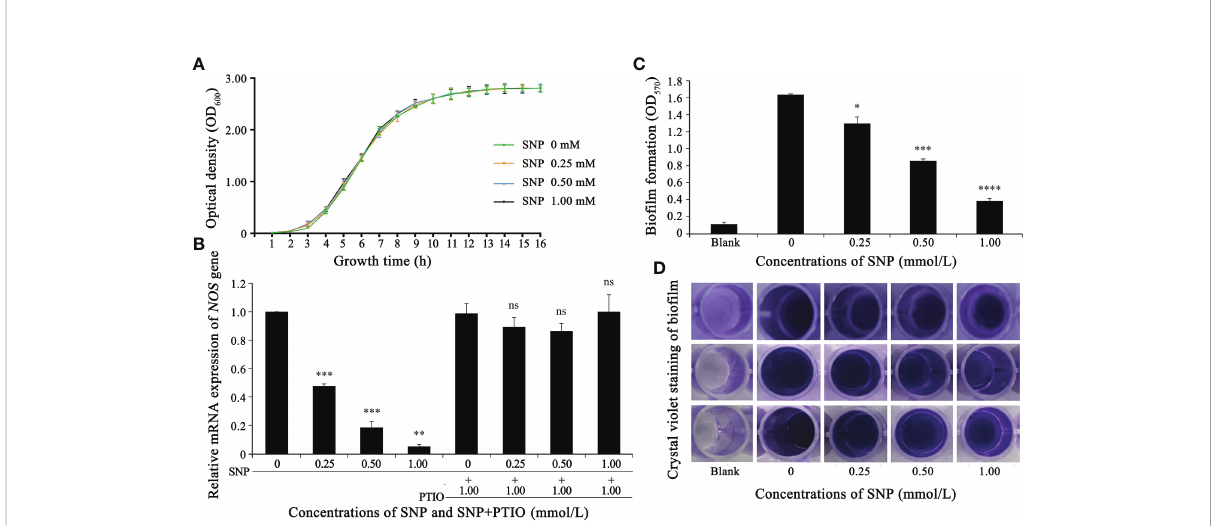
FIGURE 1 Nitric oxide donor (SNP) inhibits NOS gene expression and bio fi lm formation in S. epidermidis . (A) SNPs of 0, 0.25, 0.5 and 1 mM exhibited no signi fi cant difference in the growth of S. epidermidis (p > 0.1). (B) The effect of SNP on the NOS gene was analyzed through fl uorescent quantitative PCR (2 - △△ Ct method). (C, D) The effect of SNP on the bio fi lm formation of S. epidermidis was analyzed by crystal violet staining. Experimental data arepresented as the mean ± SDobtainedfromthree independent experiments. * p < 0.05, ** p < 0.01, *** p < 0.001, **** p < 0.0001, ns, not signi fi